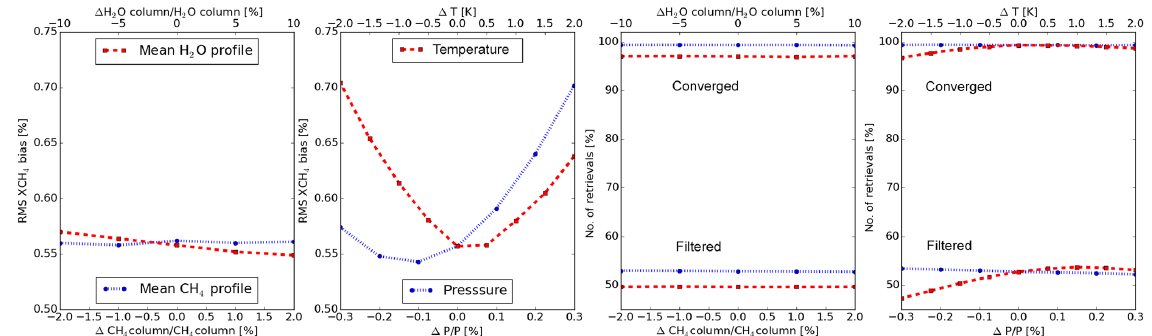
Figure 6. Influence of errors in atmospheric input on the accuracy (panels 1 and 2) and stability (panels 3 and 4) of XCH 4 retrievals. The upper and lower x axes refer to perturbations. Accuracy refers to the XCH 4 bias, and stability refers to the fraction of converged and valid retrievals. The profiles of methane and water have been perturbed in panels 1 and 3; the pressure and temperature profiles have been perturbed in panels 2 and